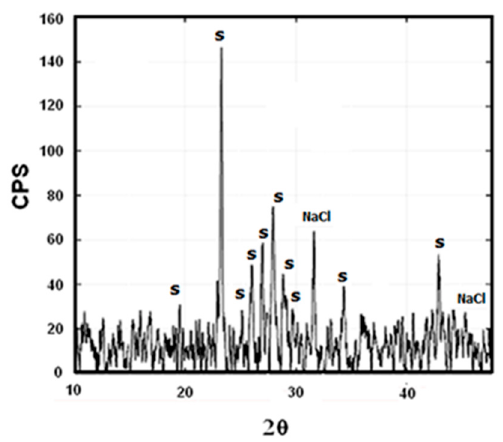
Figure 8. Diffractometric pattern of S–TiO 2 particles.